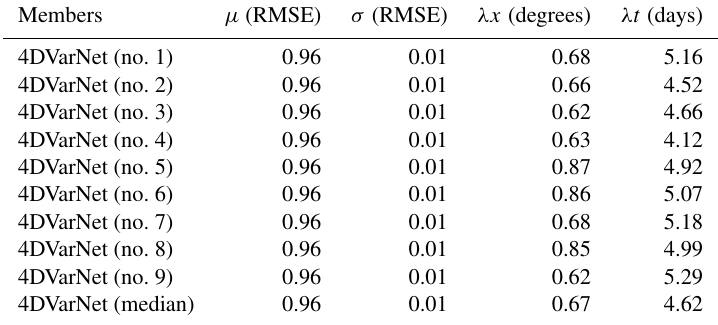
Table 5. 4DVarNet performance on the GULFSTREAM domain based on nine different training sessions with a random initialization of both (cid:56) and (cid:48) weights but similar training parameters (number of epochs, learning rates, optimizers, gradient steps, etc.) over the period from 22 October to 2 December 2012